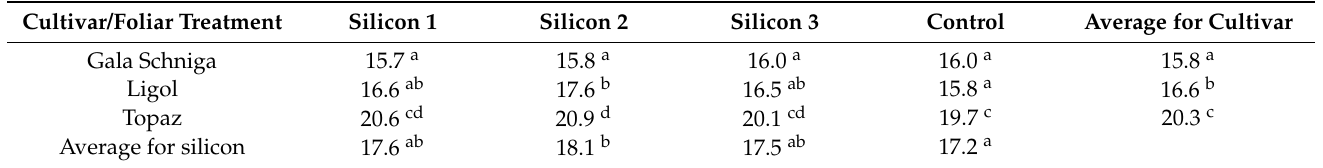
Table 10. The fruits ‘b’ parameter depends on cultivar and foliar silicon treatment.